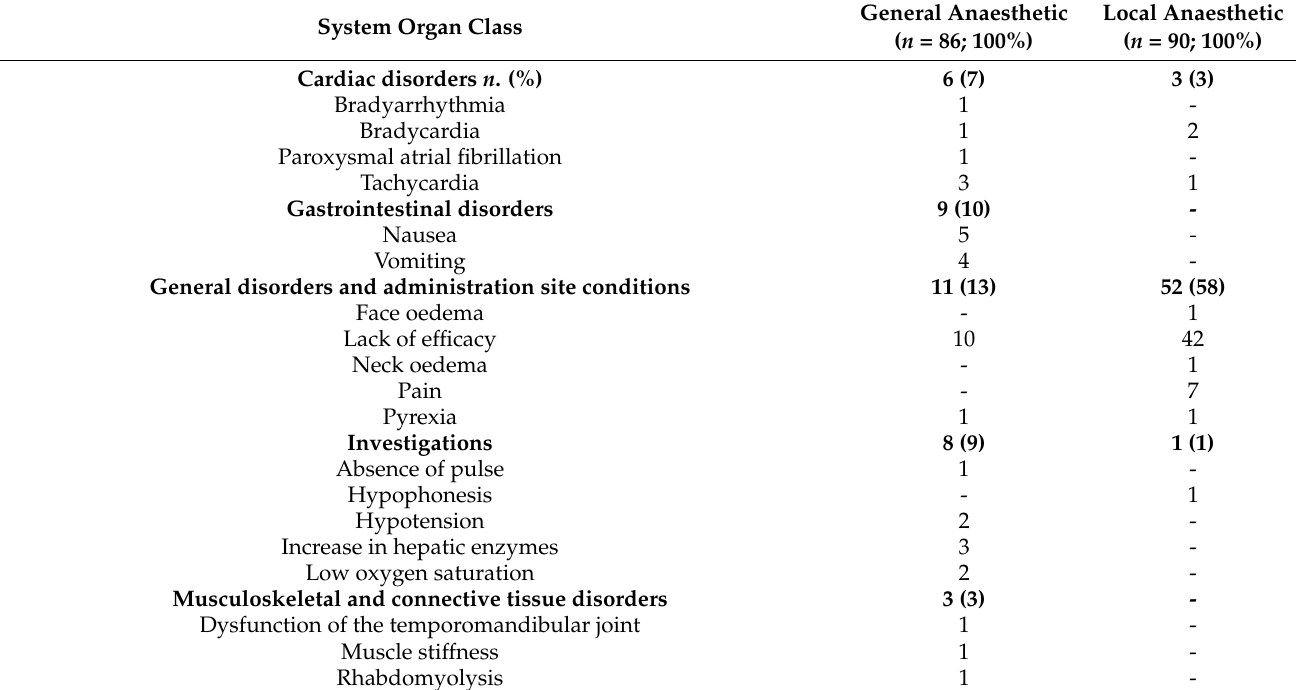
Table 4. Distribution of adverse drug reactions related to general and local anaesthetic by System Organ Classes and Preferred